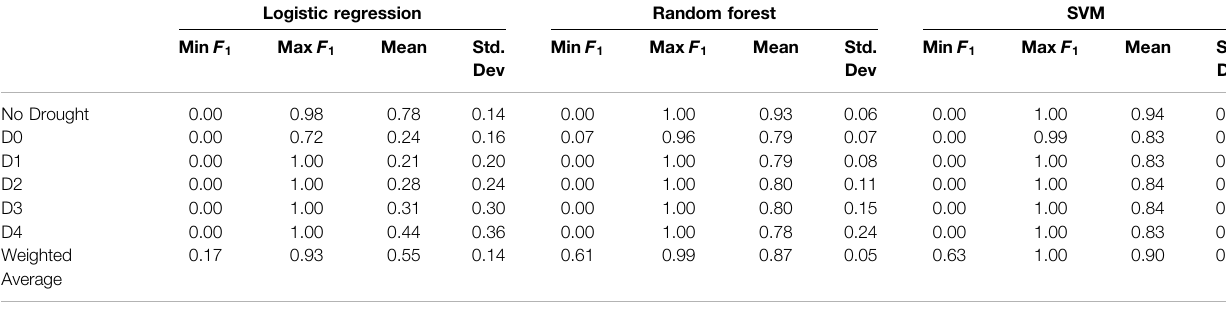
TABLE 6 | Descriptive statistics of the models performances using Group 3 input features over the entire domain. Logistic regression Random forest